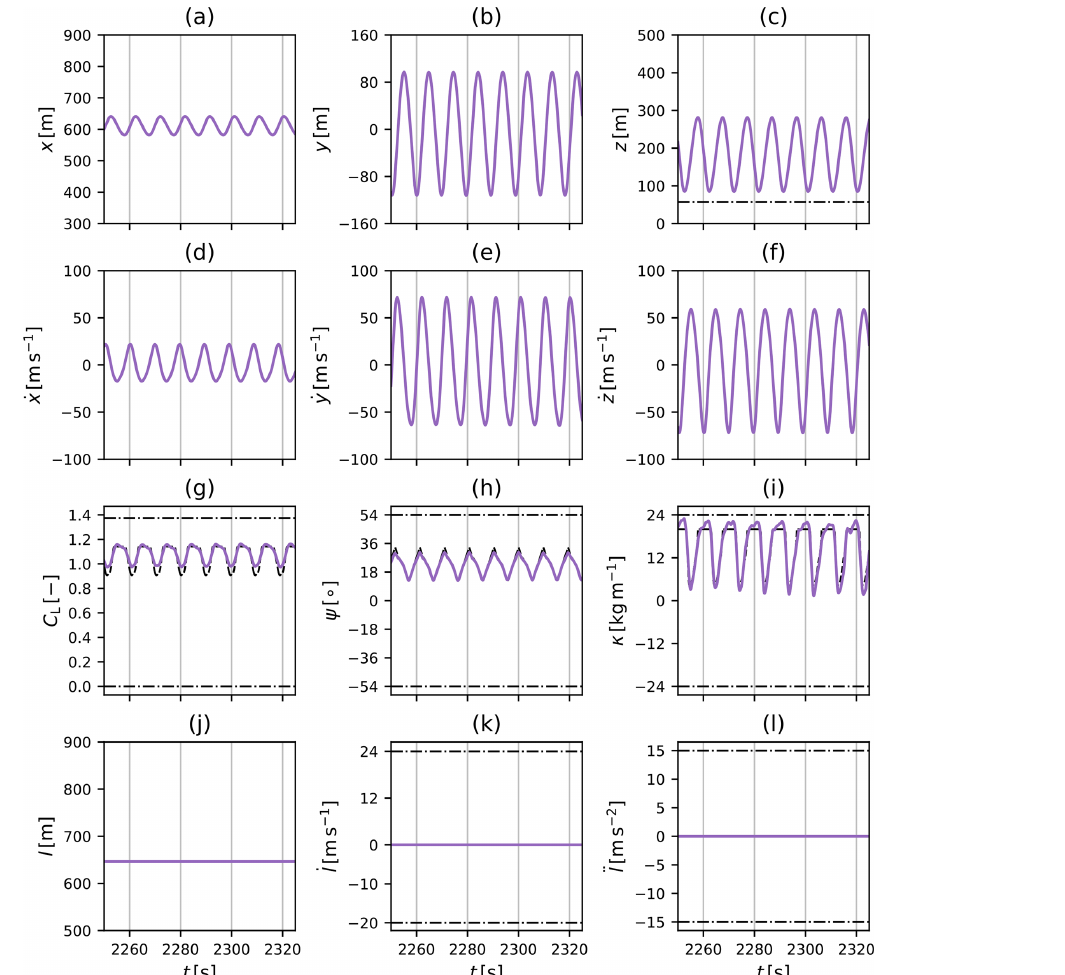
Figure B7. Instantaneous states measured at the point mass of the drag-mode AWE system 003 (park D1) compared to their reference values. The position q and velocity ˙ q are respectively shown in (a–c) and (d–f) . The wing lift coefficient C L , roll angle (cid:57) , and on-board turbine thrust coefficient κ are shown in (g–i) . The tether variables l , ˙ l , and ¨ l , representing the length, speed, and acceleration of the tether, are shown in (j–l) . The black dashed and dashed–dotted lines respectively represent the variable references and the eventual constraints applied to the variables in NMPC (Eq.